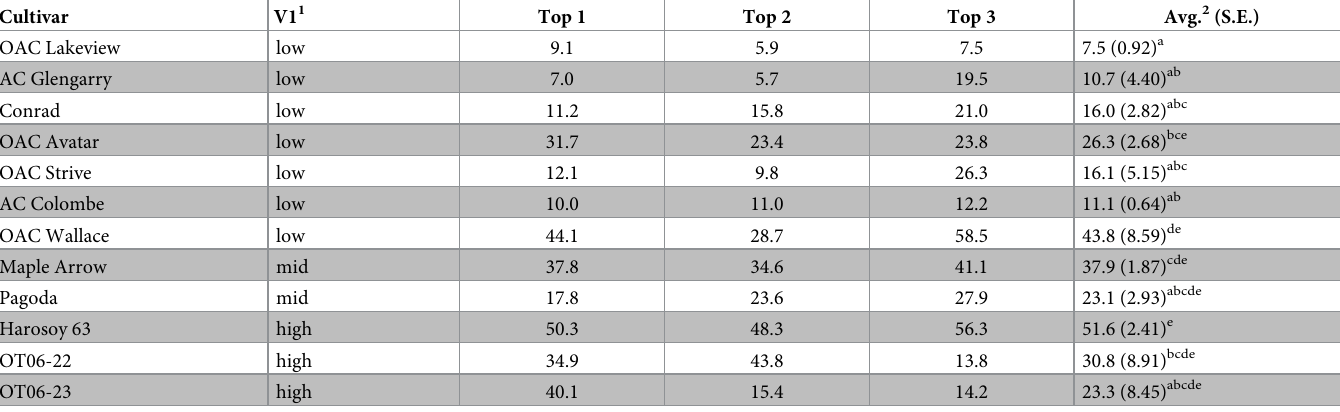
Table 2. Total isoflavonoid concentration ( μ g/g fresh weight) in control plants after the 4 week trial beginning at the V1 growth stage.